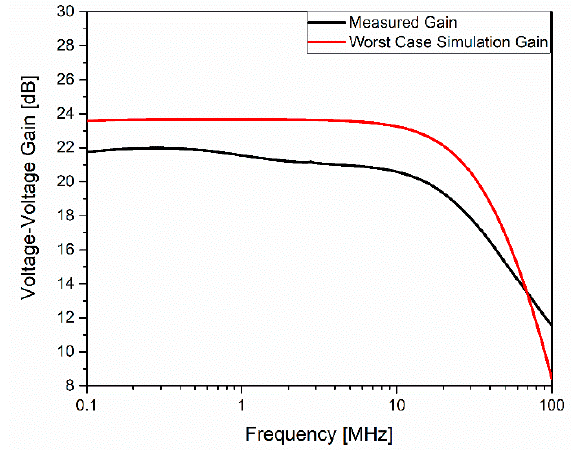
Figure 13. Transfer function of the VA amplifier.